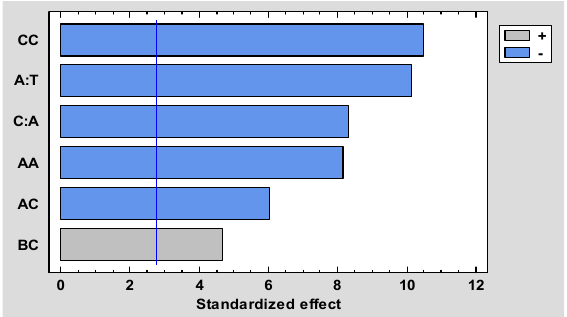
Figure 17. Effect of regression coefficients on saponin content Sp.